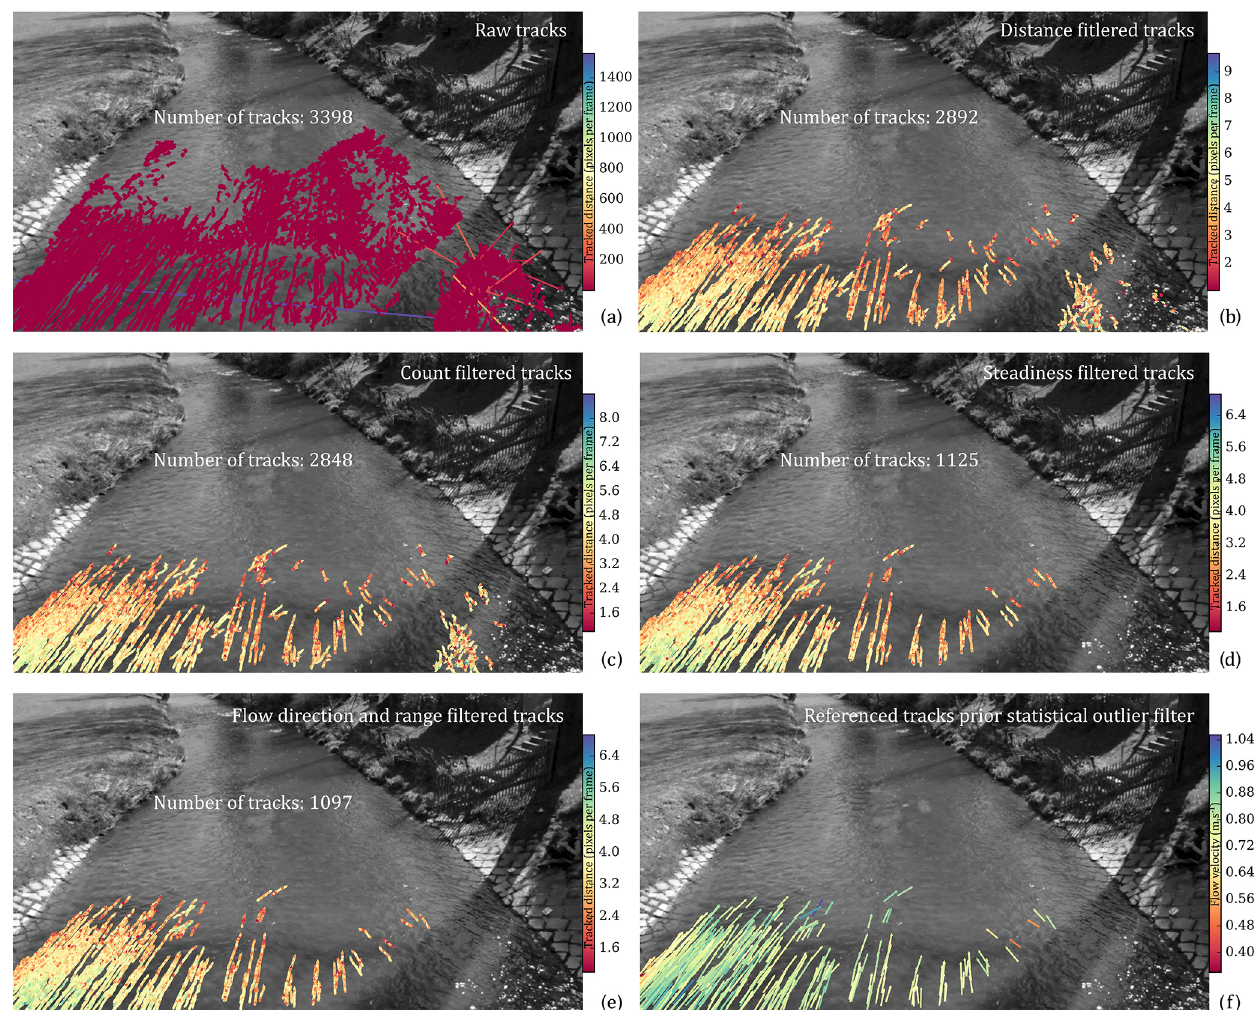
Figure 5. Result of tracked features after filtering has been applied to the video sequence of the 500D camera (with a temporal length of 23s). Sub-tracks are displayed, and the number of tracks refers to full tracks (combination of sub-tracks). (a) Raw tracks prior any filtering. (b) Filtered tracks after applying minimum and maximum distance thresholds. (c) Filtered tracks after applying a minimum count of sub- tracks over which features need to be tracked. (d) Filtered tracks after considering standard deviation of sub-track directions. (e) Filtered tracks after considering deviation from average flow direction and the range of orientation angles of sub-tracks. (f) Filtered tracks converted into metric values to receive flow velocities in metres per